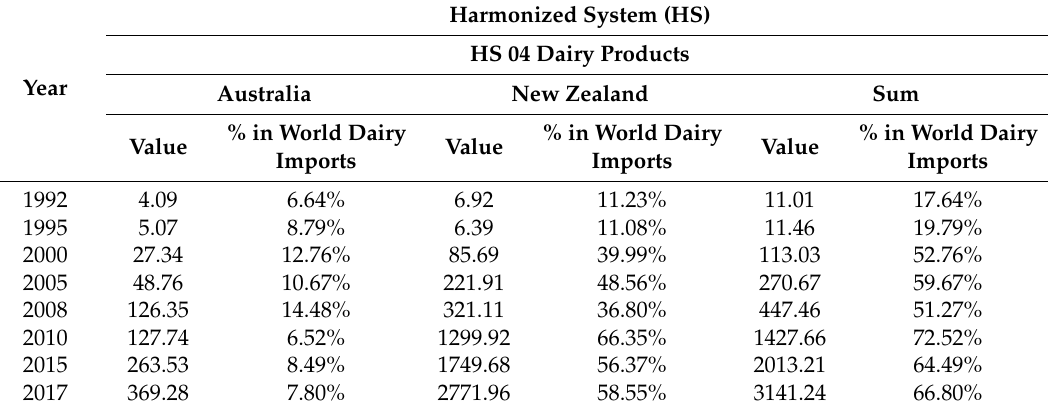
Table 3. The amount and percentage of China dairy imports from Australia and New Zealand (Unit: USD in